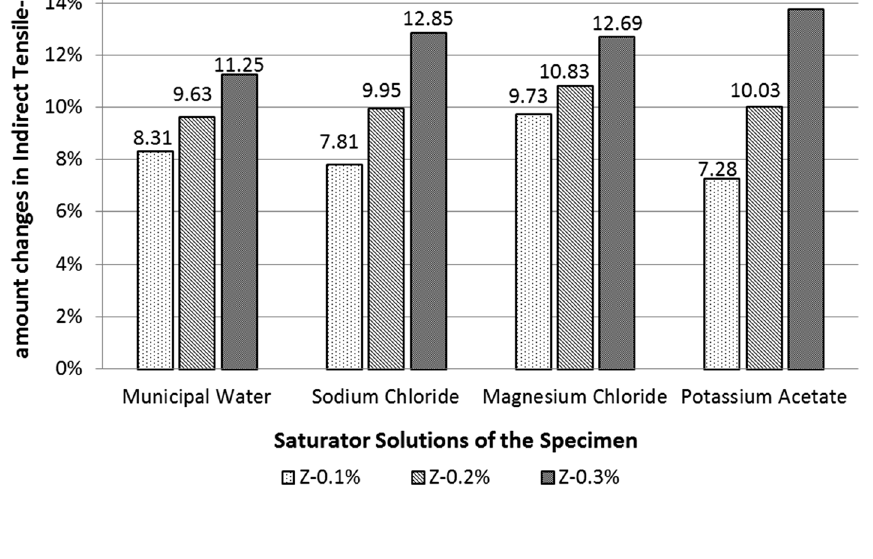
Fig. 9 Tensile Strength Ratio (TSR) of all